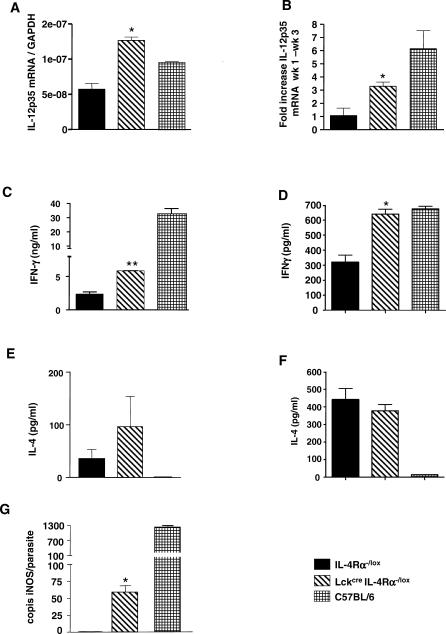
Type 1 Immunity Is Enhanced in LckcreIL-4Rα−/lox Mice in Response to L. major Infection(A and B) IL-12p35 mRNA expression is increased in resistant mice. IL-12p35 expression was determined by real-time RT-PCR from RNA prepared from pooled popliteal LN cells from week 3 L. major–infected mice (eight mice per group). Data are expressed as IL-12p35 copy numbers relative to GAPDH (A) or as fold increase in IL-12p35 mRNA from 3 wk versus 1 wk after infection (B). Mean ± SEM of three runs on the same sample. Data are representative of two independent experiments (*p < 0.05, LckcreIL-4Rα−/lox versus WT).(C and D) Increased IFN-γ production in resistant mice. (C) IFN-γ secretion by CD4 T cells cultured with fixed APCs and SLA. (**p < 0.01, LckcreIL-4Rα−/lox versus WT) and in (D) footpad homogenates (*p < 0.05, LckcreIL-4Rα−/lox versus WT) (homogenate data represent the pool of two independent experiments) from week 10 L. major–infected mice.(E and F) Maintained IL-4 production in resistant mice. (E) IL-4 secretion by CD4 T cells cultured with fixed APCs and SLA and in (F) footpad homogenates from week-ten L. major–infected mice.(G) iNOS production. iNOS mRNA copy number was calculated from footpad mRNA 6 wk after infection with L. major. At the same time, parasite DNA copy number was quantitated by PCR detecting L. major kinetoplast DNA. (*p < 0.05 LckcreIL-4Rα−/lox versus WT). The data represent the means of two individual experiments ± SEM.